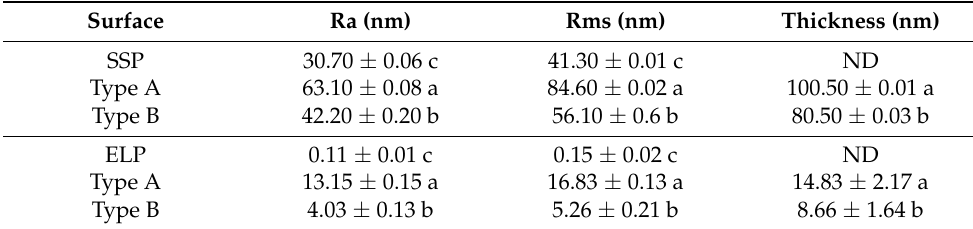
Table 5. Surface roughness of SSP and ELP plates with and without type A and B deposits.